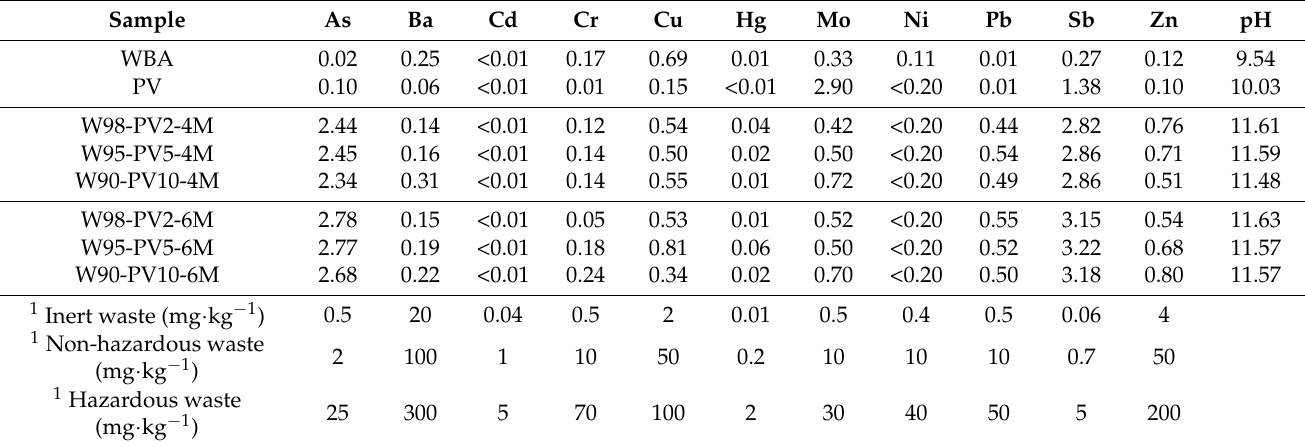
Table 5. Leaching concentrations (mg · kg − 1 ) in WBA, PV, and AA-WBA/PV binders after leaching tests (EN 12457-2) and limits for acceptance at